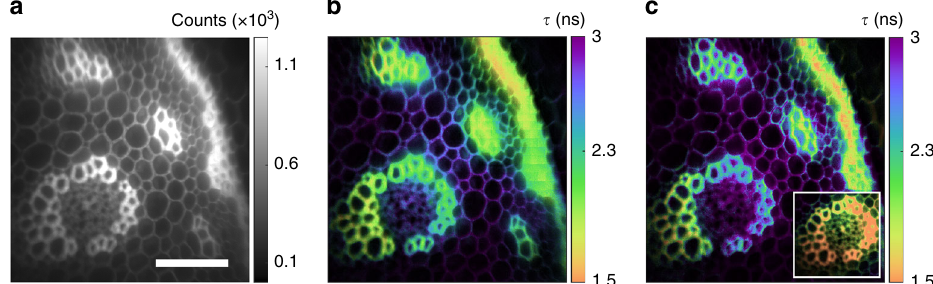
Fig. 4 Fast FLIM with a thin PC. a Intensity image of Convallaria majalis rhizome stained with acridine orange, a standard FLIM benchmark (scale bar 100 μ m). b Lifetime image from fi tting a timing trace of 100 ms exposures (50 μ W excitation). c Lifetime image from a single 100 ms acquisition frame. Inset demonstrates the same single frame with 2 ms exposure at high excitation intensity (3 mW — high intensity signi fi cantly reduced lifetime in this sample, possibly due to photochemistry). Lifetime images include an intensity mask to show sample